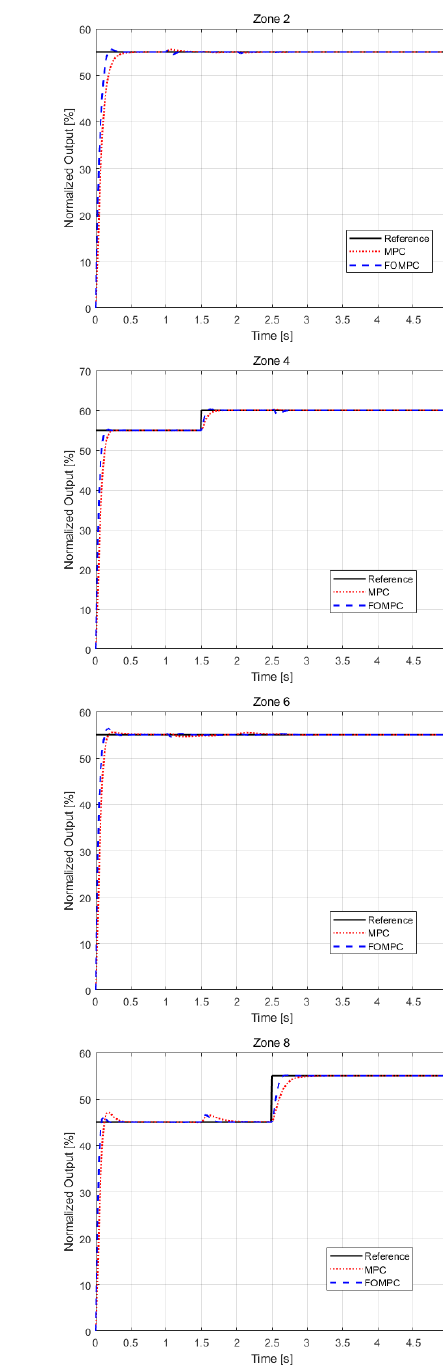
Figure 4. Output of multiple lighting control with MPC and FOMPC in reference tracking simula ‐ tion.